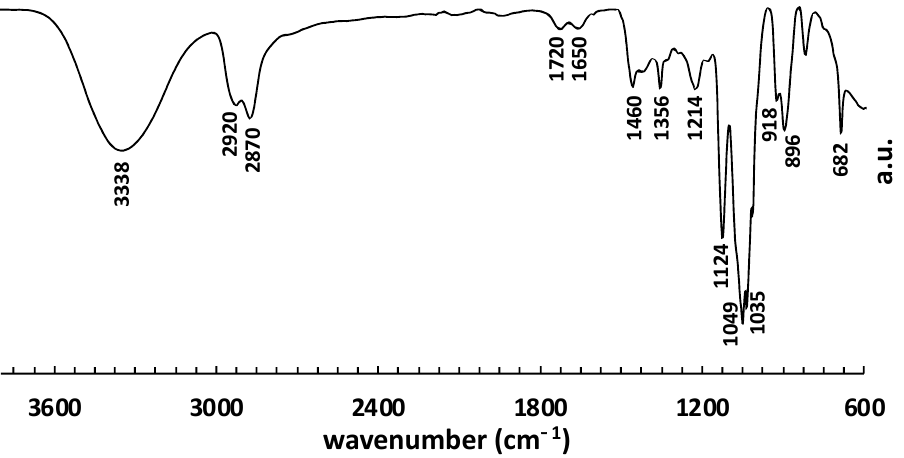
Figure 6. FTIR-ATR spectra of aqueous extract of bio-oil of Eucalyptus globulus .